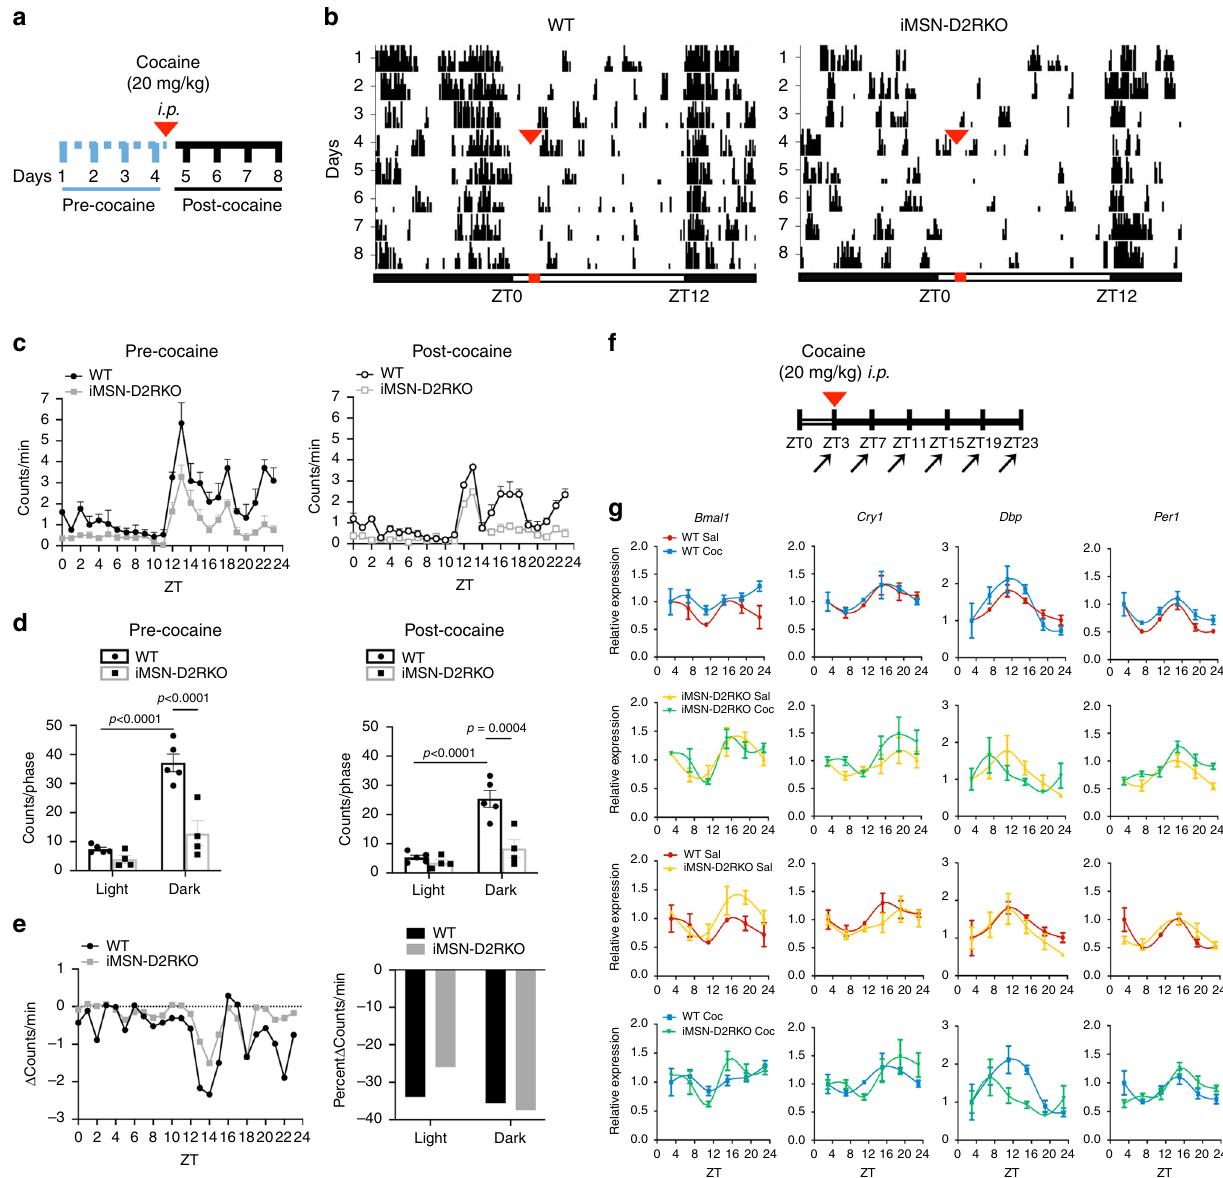
Fig. 1 Effects of acute cocaine on circadian clock genes. a Schematic of the experimental design in b . b Actograms of 24h locomotor activity in 12h-Light/ 12h-Dark cycles in WT ( n = 5) and iMSN-D2RKO mice ( n = 4) during the 4 days preceding and following cocaine administration. Cocaine (20 mg kg -1 , i.p.) was given once at ZT3 on day 4 (red arrowheads in 1a and 1b). c Locomotor activity analyses from b in WT (circles) and iMSN-D2RKO (squares) mice. Graphical representation of the number of beam breaks/min/circadian time (ZT) during the days preceding (Pre-Cocaine; left) or following cocaine injection (Post-Cocaine; right). d Total beam breaks per phase in WT (circles) ( n = 5) and iMSN-D2RKO (squares) ( n = 4); inactive phase (Light), active phase (Dark), Pre-cocaine (two-way ANOVA, Genotype: F (1, 14) = 27.31, p = 0.0001; Time: F (1, 14) = 52.41, p <0.0001; Interaction: F (1, 14) = 15.20, p = 0.0016) and Post- cocaine (two-way ANOVA, Genotype: F (1, 14) = 18.15, p = 0.0008; Time: F (1, 14) = 31.86, p <0.0001; Interaction: F (1, 14) = 12.01, p = 0.0038). Tukey ’ s multiple comparison test p -values as indicated. e Left: The mean change in counts/min at each time point in pre-cocaine vs post-cocaine time in WT (circles) and iMSN-D2RKO (squares). Right: same as e) left , but represented as percent change during the light (ZT0-11) and dark (ZT12-23) phases. f Schematic of the circadian experimental design in g. Mice were injected with cocaine (20 mg kg − 1 , i.p) at ZT3 and NAcc samples were collected every 4h following cocaine injection at ZT 3, 7, 11, 15, 19 and 23 (arrows). g Expression of core clock and clock-controlled genes: Bmal1, Cry1, Dbp , and Per1 in WT saline (Sal; red circles) or cocaine (Coc; blue squares) and iMSN-D2RKO (Sal; yellow upward triangles) or (Coc; green downward triangles) analyzed by quantitative real-time PCR ( n = 3/genotype) (three-way ANOVA ; For statistics see Supplementary Table 1). Data are presented as mean values ±